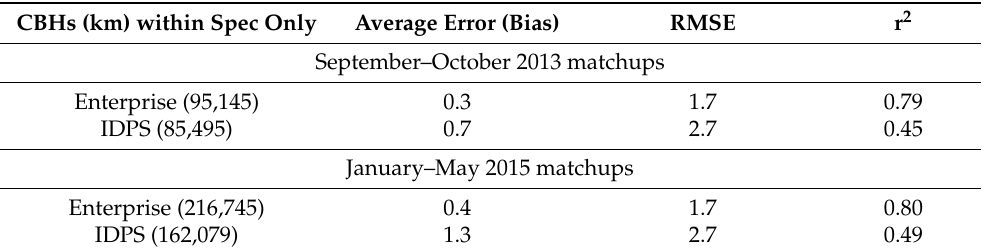
Table 1. Error statistics of the new algorithm and IDPS CHBs from S- NPP VIIRS–CloudSat match- ups (Modified from Noh et al. [50]). CBHs (km) within Spec Only